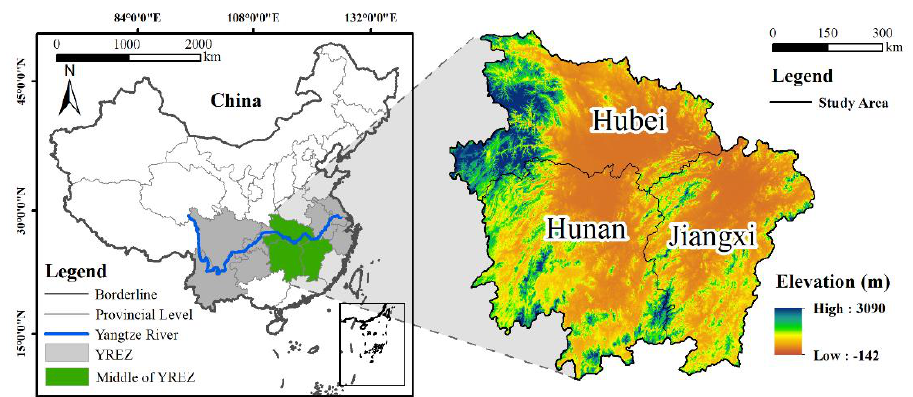
Figure 1. Locations of the middle reaches of the Yangtze River (MRYR).